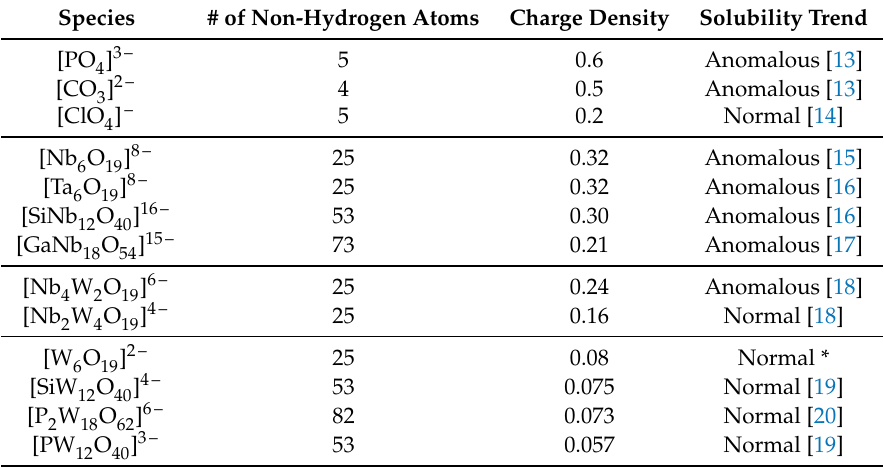
* Only soluble in organic solvents